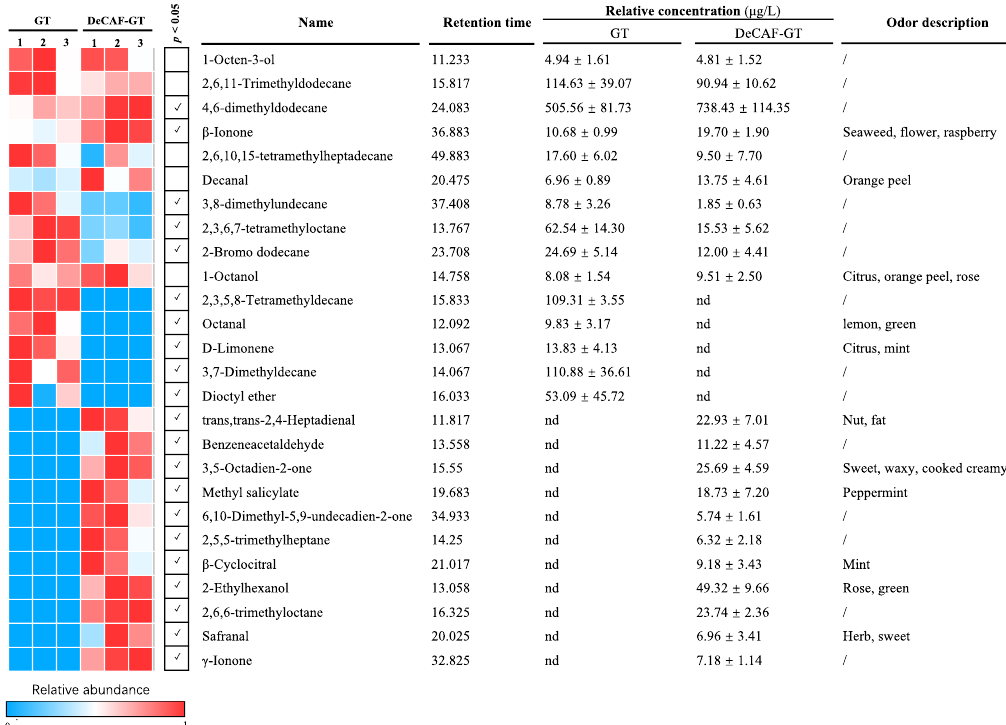
Figure 3. Non-volatiles in the green tea (GT), decaffeinated green tea (DeCAF-GT). Notes: the odor description was referenced from http://www.flavornet.org. (Accessed on 10 September 2022) The blue and red squares indicate the relative abundance of volatiles from 0 to 1, respectively. Abbreviations: not detected (nd).